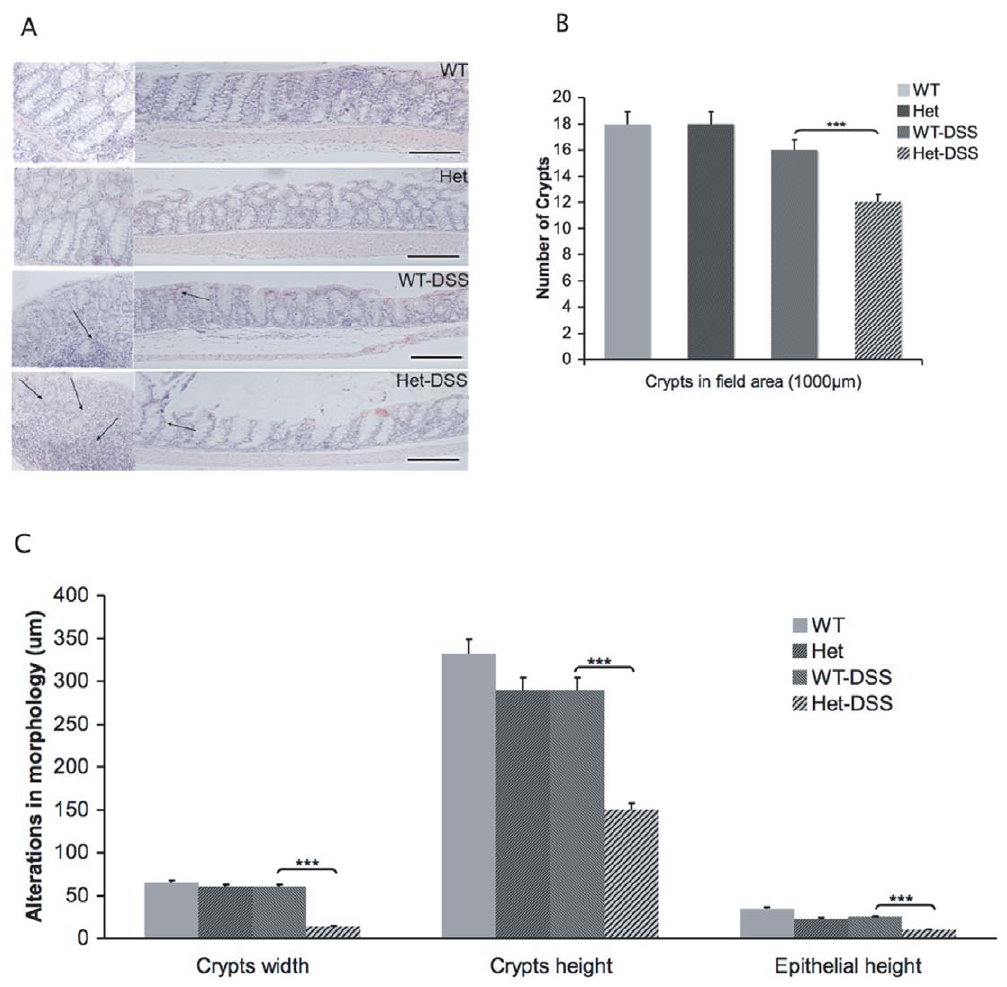
Figure 2. Loss of colorectal crypt-villi. A. Histopathological features of the mouse colon in association with colitis. Bar=1000 m m. From top to bottom: TC-PTP + / + (WT), TC-PTP + / 2 (Het), DSS-treated TC-PTP + / + (WT-DSS) and DSS-treated TC-PTP + / 2 (Het-DSS). In TC-PTP + / + (WT) crypts are straight and the base of the glands reach the muscularis mucosae. Crypt-villus axes are normal and epithelium layer is intact. In DSS-treated TC-PTP + / 2 (Het-DSS) mice ingestion of DSS caused crypt destruction, Numerous neutrophils were present in the section (arrows). Loss of the surface epithelial layer is obvious, while changes in crypt-villus axis and colon tissue architecture are observed. B. The number of crypts per field, field is 1000 m m in colorectal section of bowel. The number of crypts in DSS-treated TC-PTP + / 2 (Het-DSS) mice were significantly lower than DSS-treated TC-PTP + / + (WT-DSS) mice p , 0.002. C. Crypts in field, crypts width, crypts height and epithelial height were quantified. Data represent mean and SD of three groups of three animal each (N=9).